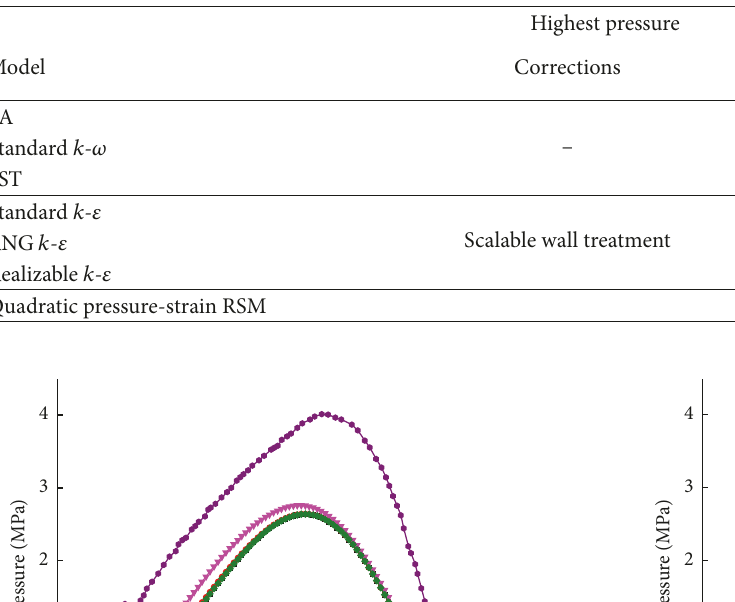
Table 7: Highest pressure of the classical full–developed turbulence models group.